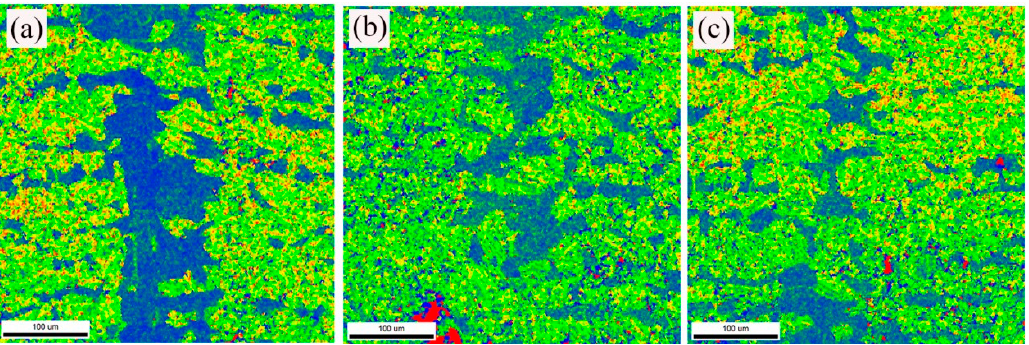
Figure 14. KAM maps of the weld zone of creep samples for different stresses: ( a ) 3-550-160, ( b ) 3-550-180, and ( c ) 3-550-220.